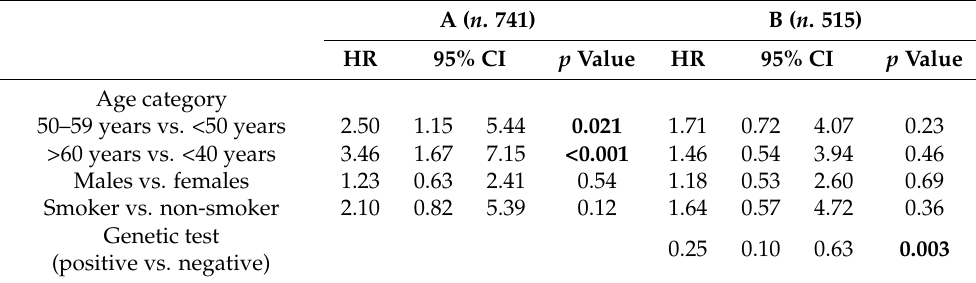
Table 5. Multivariable analysis for the risk of developing a malignant tumor excluding patients with a second tumor developed before or simultaneously with the chromaffin tumor (A) and limited to the patients with genetic evaluation (B).